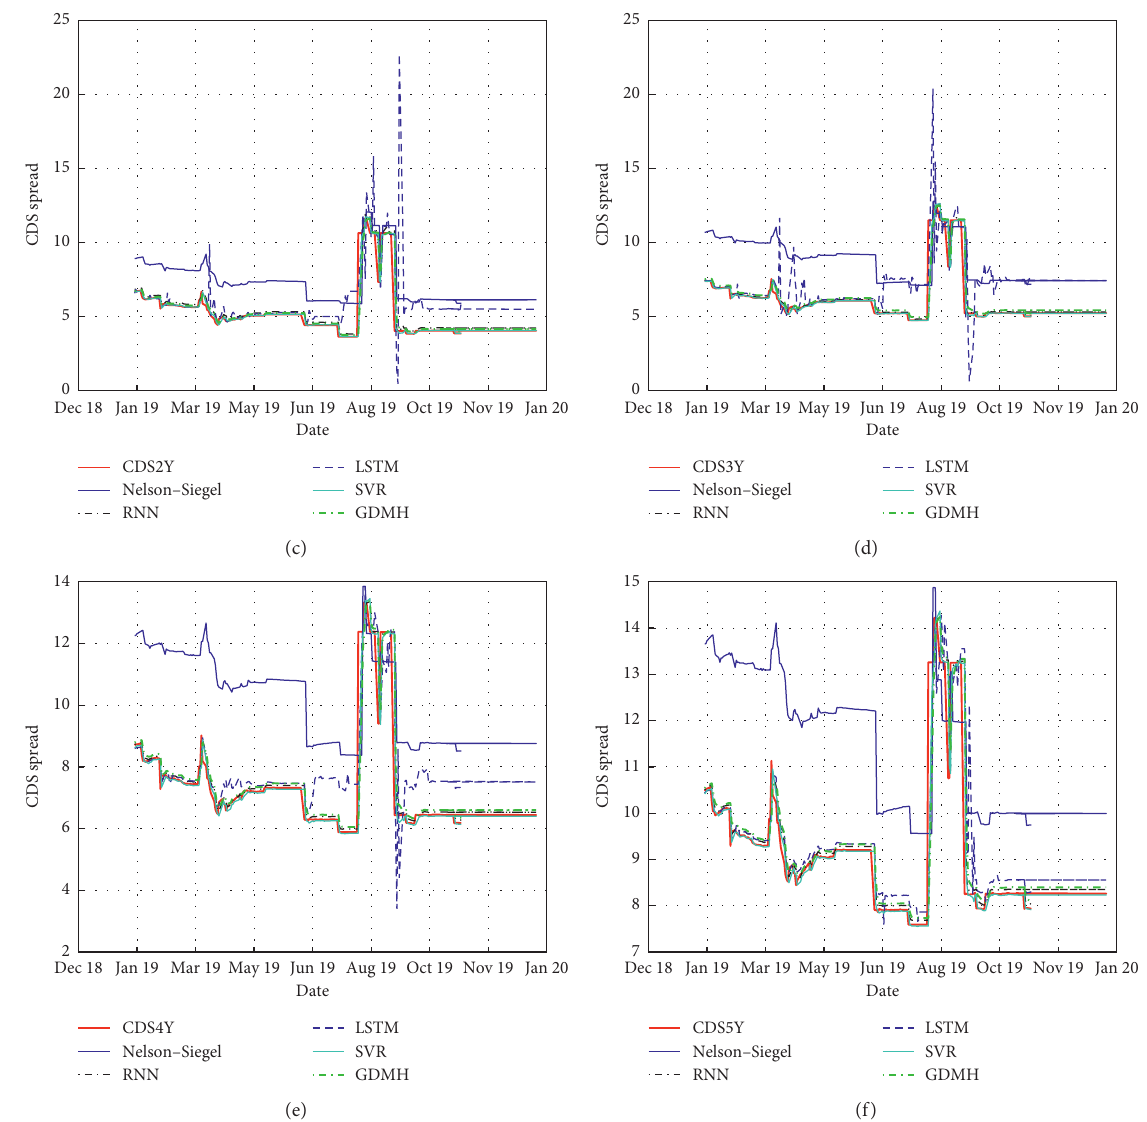
Figure 6: Predictions of each model and target CDS term structure from six months to five years maturity for test dataset 1 with the full period training set (case